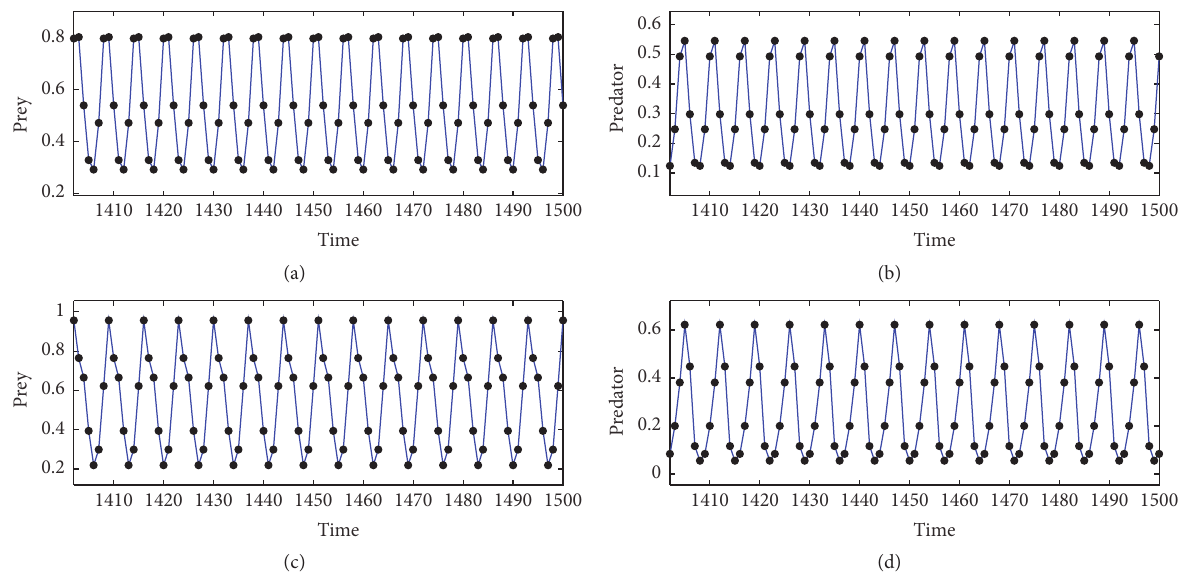
Figure 4: Several different types of typical solutions of system (6). The parameter values are fixed as follows: 𝑝 = 0.1, 𝜏 = 0.3, 𝜎 = 0.66, 𝛽 = 4, 𝛼 = 3, 𝛿 = 2.0 , and ET = 0.6. (a-b) The initial density of prey and predator (𝑥 that there exists another attractor that tends to infinity (not shown